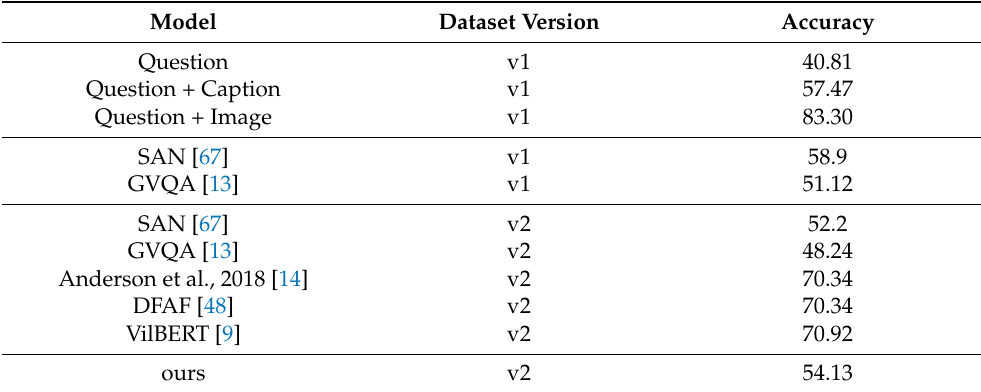
Table 7. Experimental results on VQA task. Top part shows human